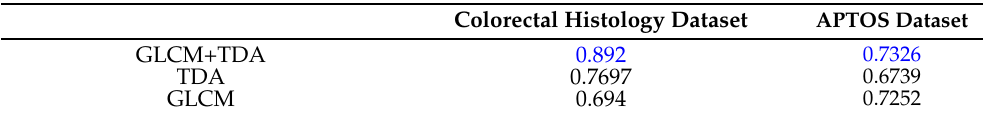
Figure 16. Confusion matrix for the Mangopest dataset with ResNet 1D implementation. Table 4. Comparison of performance of GLCM+TDA, TDA feature-only, and GLCM-only imple- mented by 1D ResNet model on two